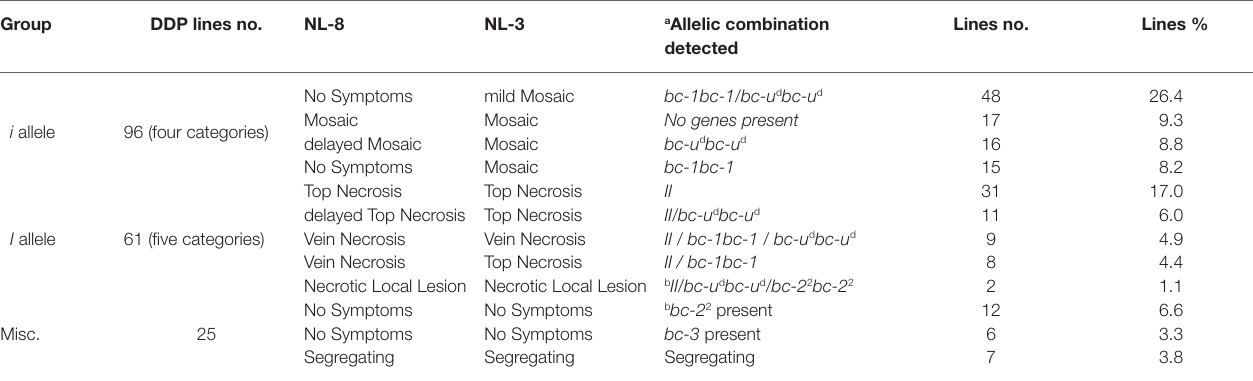
TABLE 2 | Phenotypic reactions to BCMNV isolates NL-8 and NL-3observed in Durango Diversity Panel (DDP; 182 lines), classified into two major groups: recessive I gene vs. dominant I gene, with four and five phenotype sub-categories, respectively. Group DDP lines